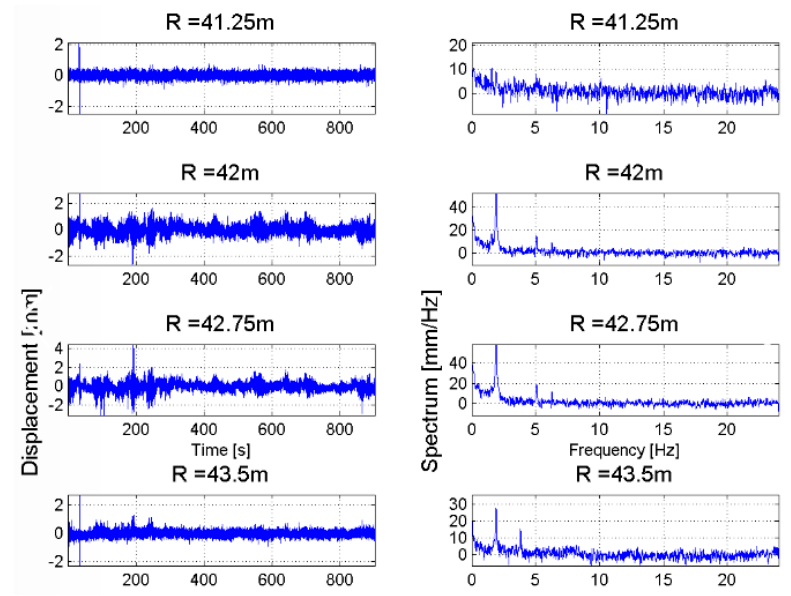
Figure 16. Occhito dam, Carlantino. Time series of displacements ( left ) and corresponding frequency spectrum ( right ) of targets belonging to the pedestrian bridge located at range distance in the interval [40 m, 45 m].